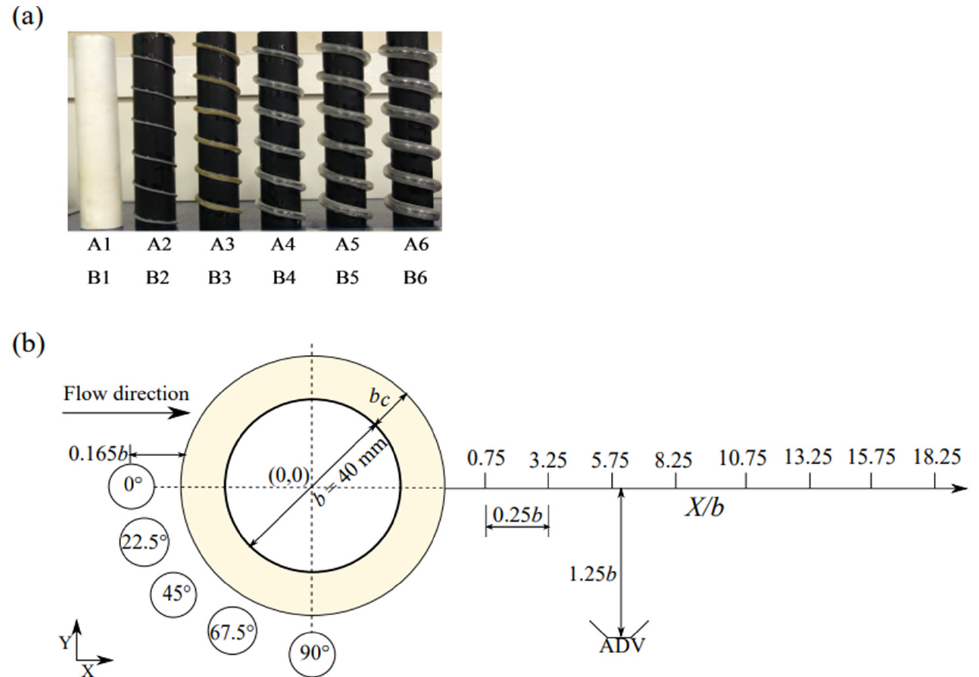
Figure 1. ( a ) Model bridge piers with diameter b = 40 mm of varying cable diameter to cable ratio (left to right): no cable (A1 and B1); 2 mm (A2 and B2); 4 mm (A3 and B3); 6 mm (A4 and B4); 8 mm (A5 and B5); and 10 mm (A6 and B6). ( b ) Plan view of the side-looking ADV probe sampling volume locations around the pier.